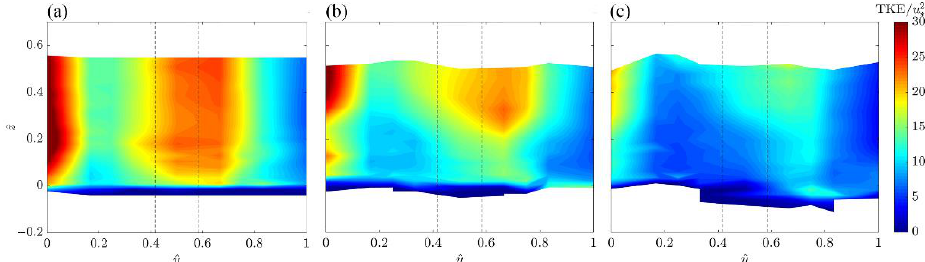
Figure 8. Contours of the dimensionless TKE in the upstream plane section (from LE to RE) for ( a ) Run 1, ( b ) Run 2 and ( c ) Run 3. The black dashed lines show the cylinder position.